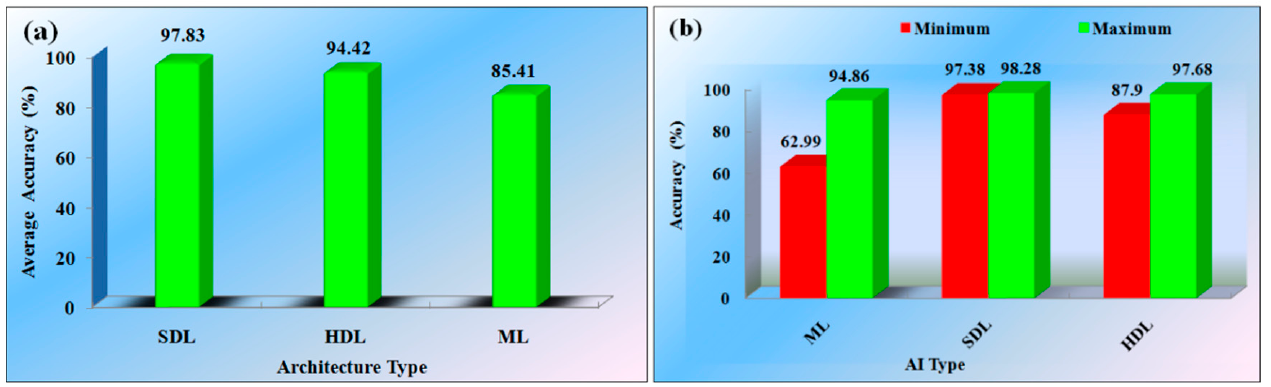
Figure 4. ( a ) Average accuracy of the various architectures for PD. ( b ) Minimum (red) and maximum (green) accuracy of the different PD architecture (AI: Artificial Intelligence, SDL: Solo deep learning, ML: Machine learning, HDL: Hybrid deep